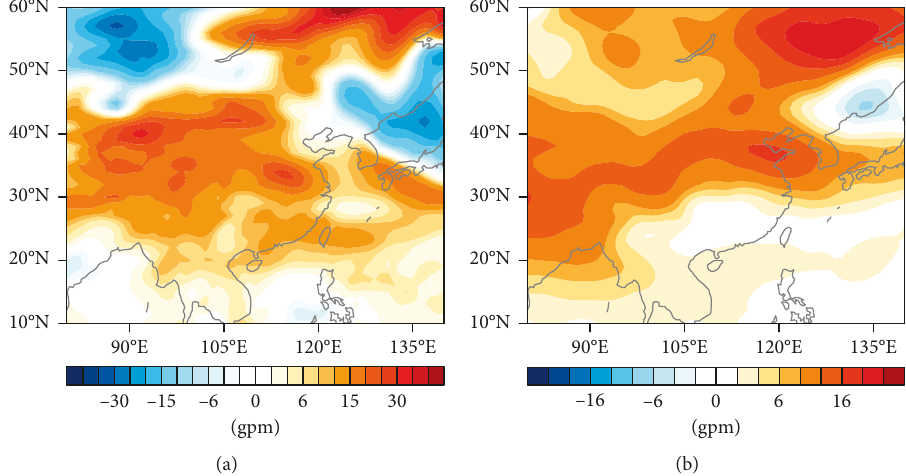
Figure 4: 48h nonsystematic error of geopotential height on 500hPa on January 15, 2010 (unit: gpm): (a) nonsystematic error and (b) nonsystematic error estimated by variational